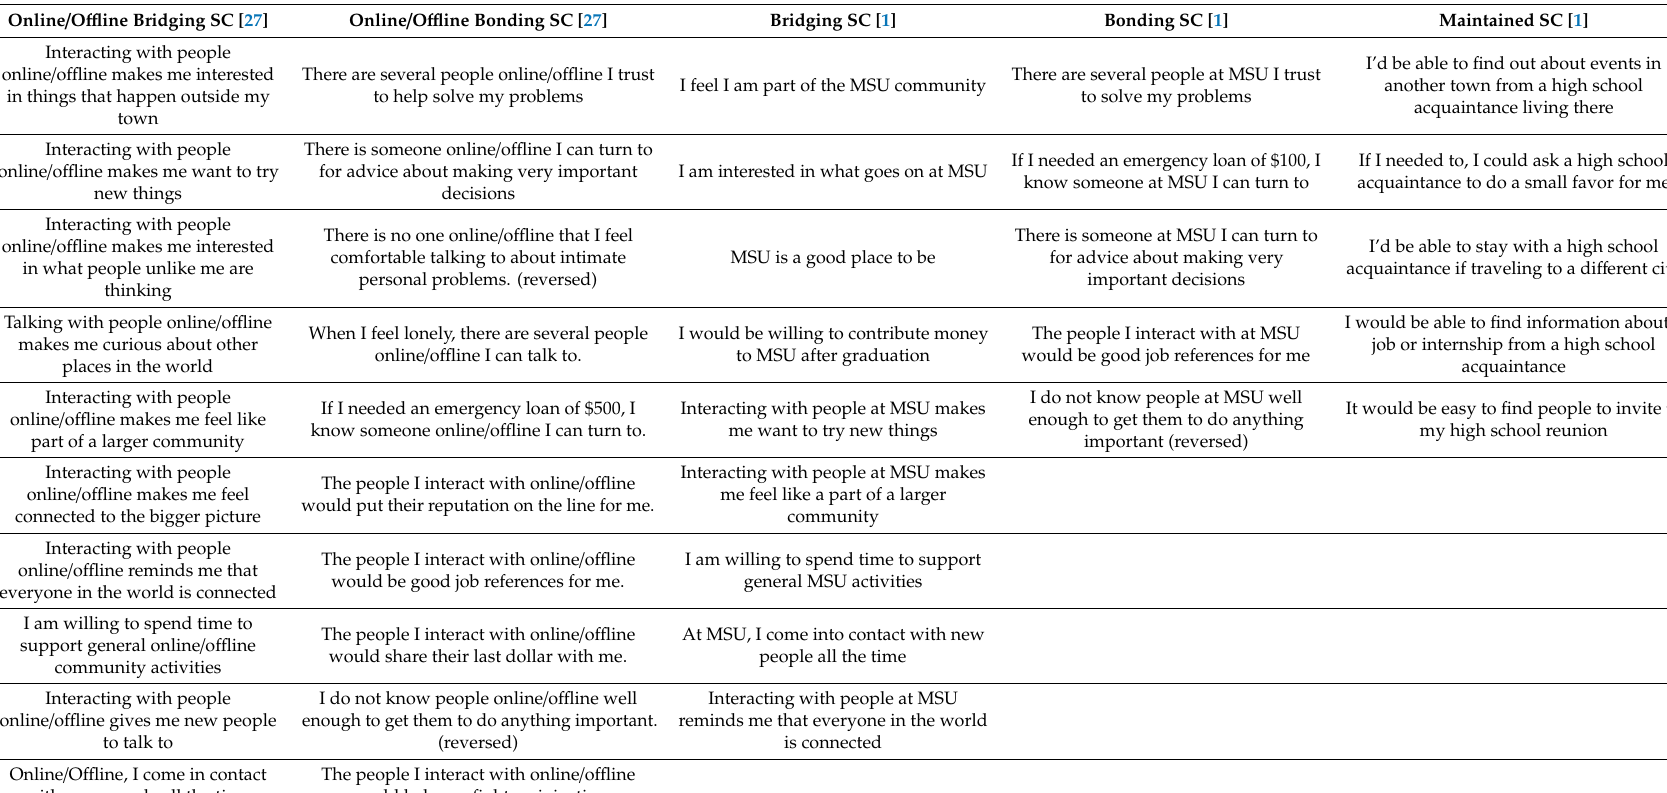
Table 1. Comparison of measurement items from Williams’ Internet Social Capital Scale (ISCS) with measurement items from Ellison et al. (2007). MSU: Michigan State